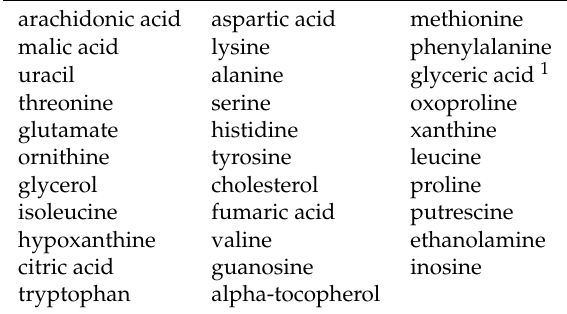
Table 2. ST000061 metabolites higher in visceral tissue than subcutaneous tissue.